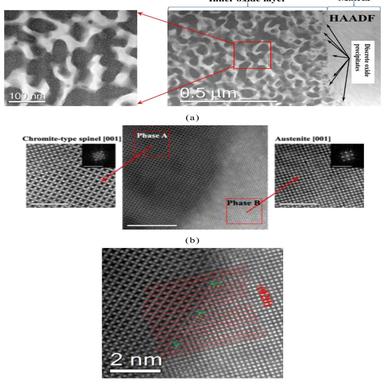
(a) HAADF image showing a two-phase structure in the inner oxide layer (TEM sample 1); (b) atomic-resolution HAADF images showing that the inner oxide layer consists of chromite-type spinel and austenitic phases (TEM sample 1); (c) atomic-resolution HAADF image showing a semi-coherent interface between the oxide phase and the metal phase in the inner oxide layer (TEM sample 1).